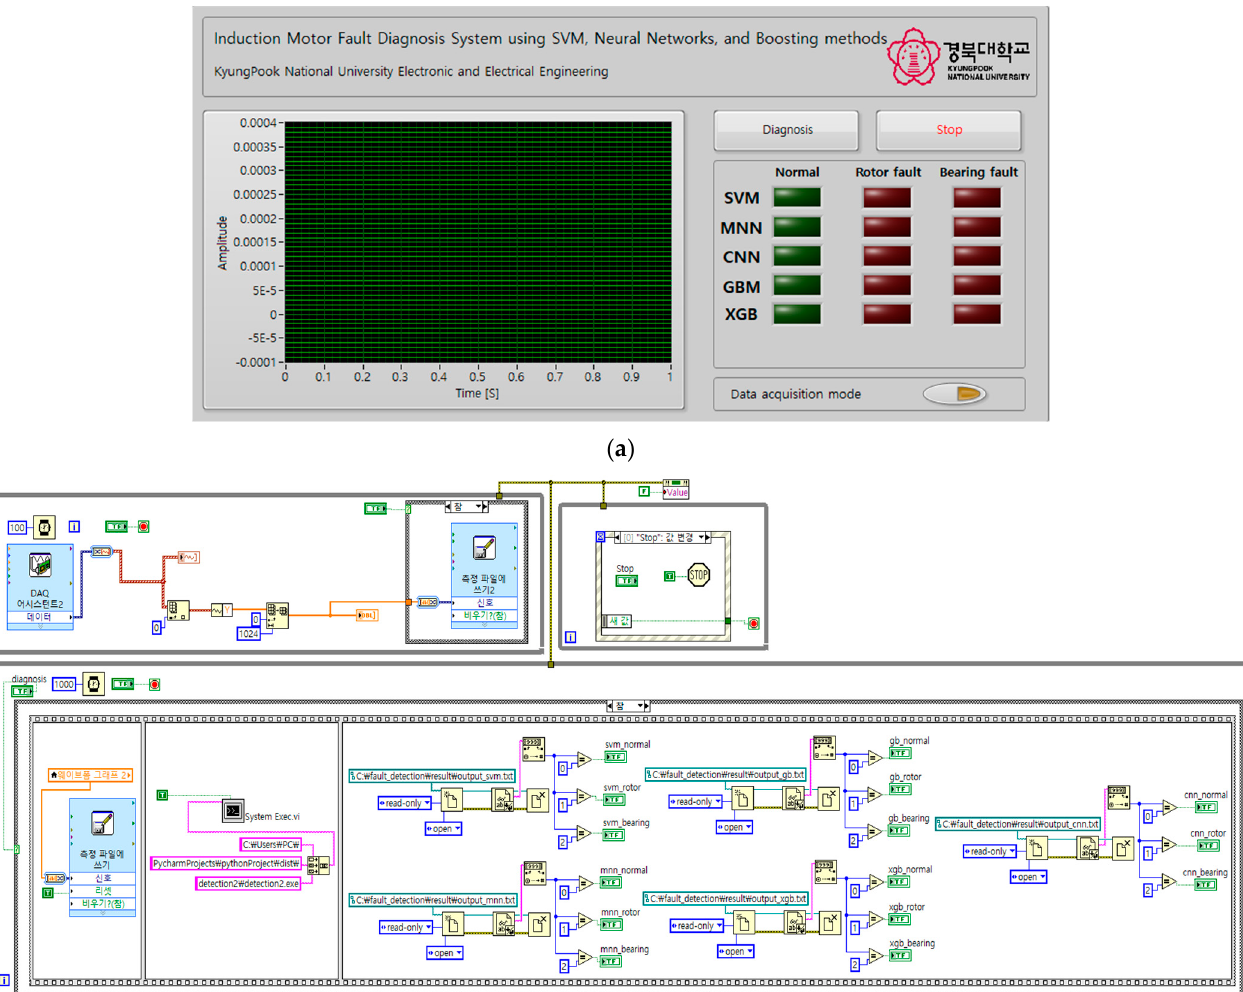
Figure 11. Graphical user interface of fault diagnosis in induction motor. ( a ) Front panel of LabView program for fault diagnosis in induction motor graphical user interface. ( b ) Front panel of LabView program for fault diagnosis in induction motor graphical user interface.